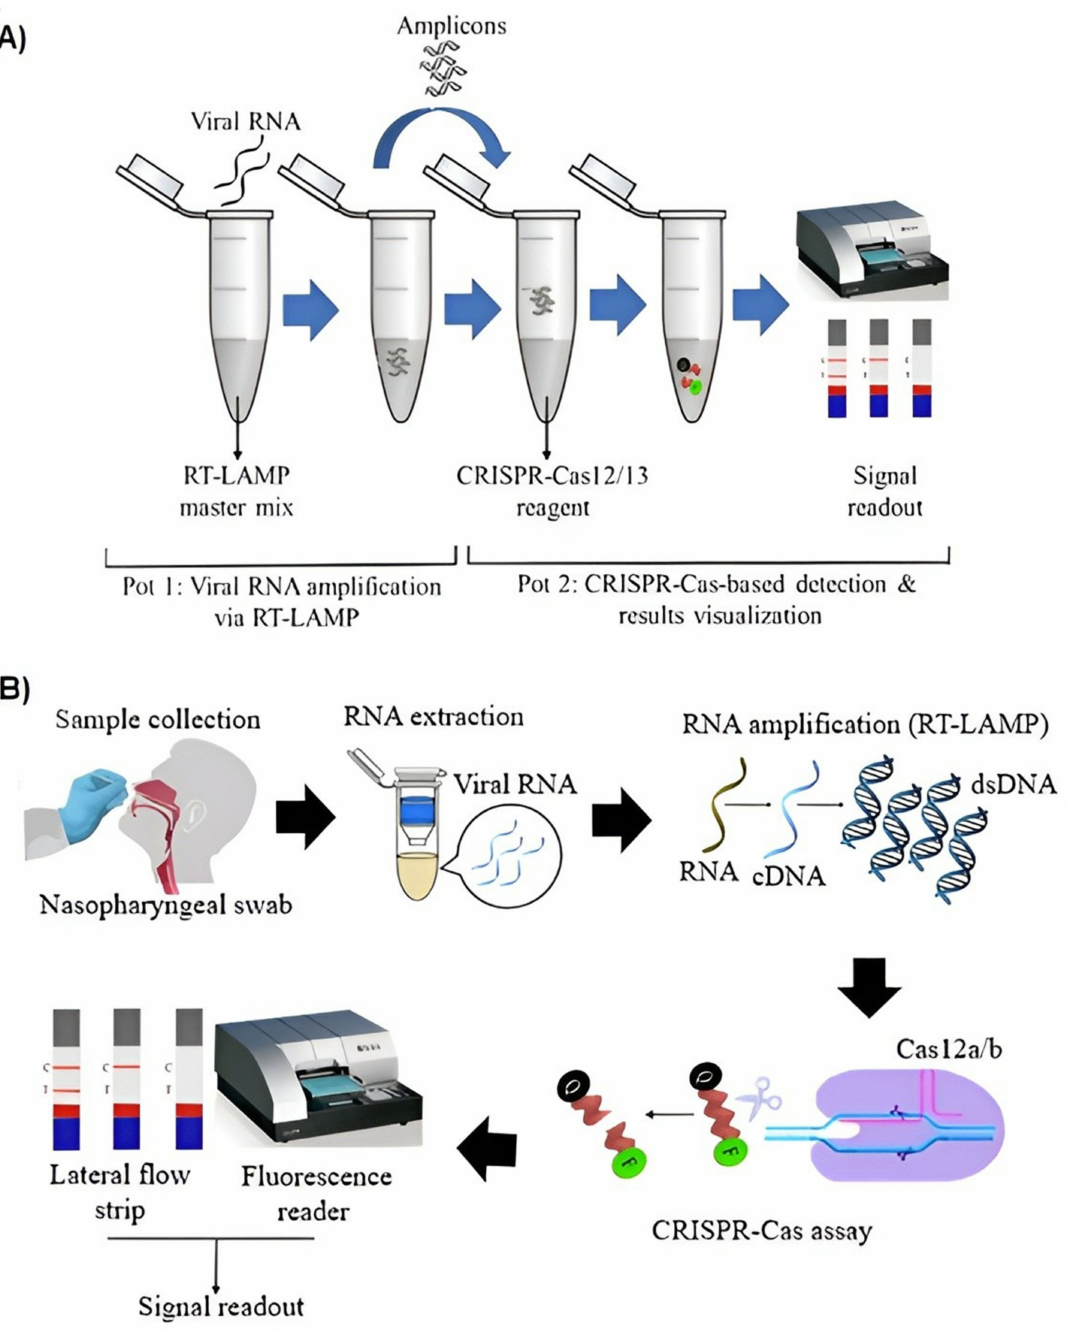
Figure 2. CRISPR/Cas technology. ( A ) Experimental process of CRISPR/Cas integrated LAMP technology [41]. ( B ) Schematic representation of the CRISPR/Cas combined LAMP diagnostic tests developed for the detection of SARS-CoV-2 [41]. Reprinted from Ref.